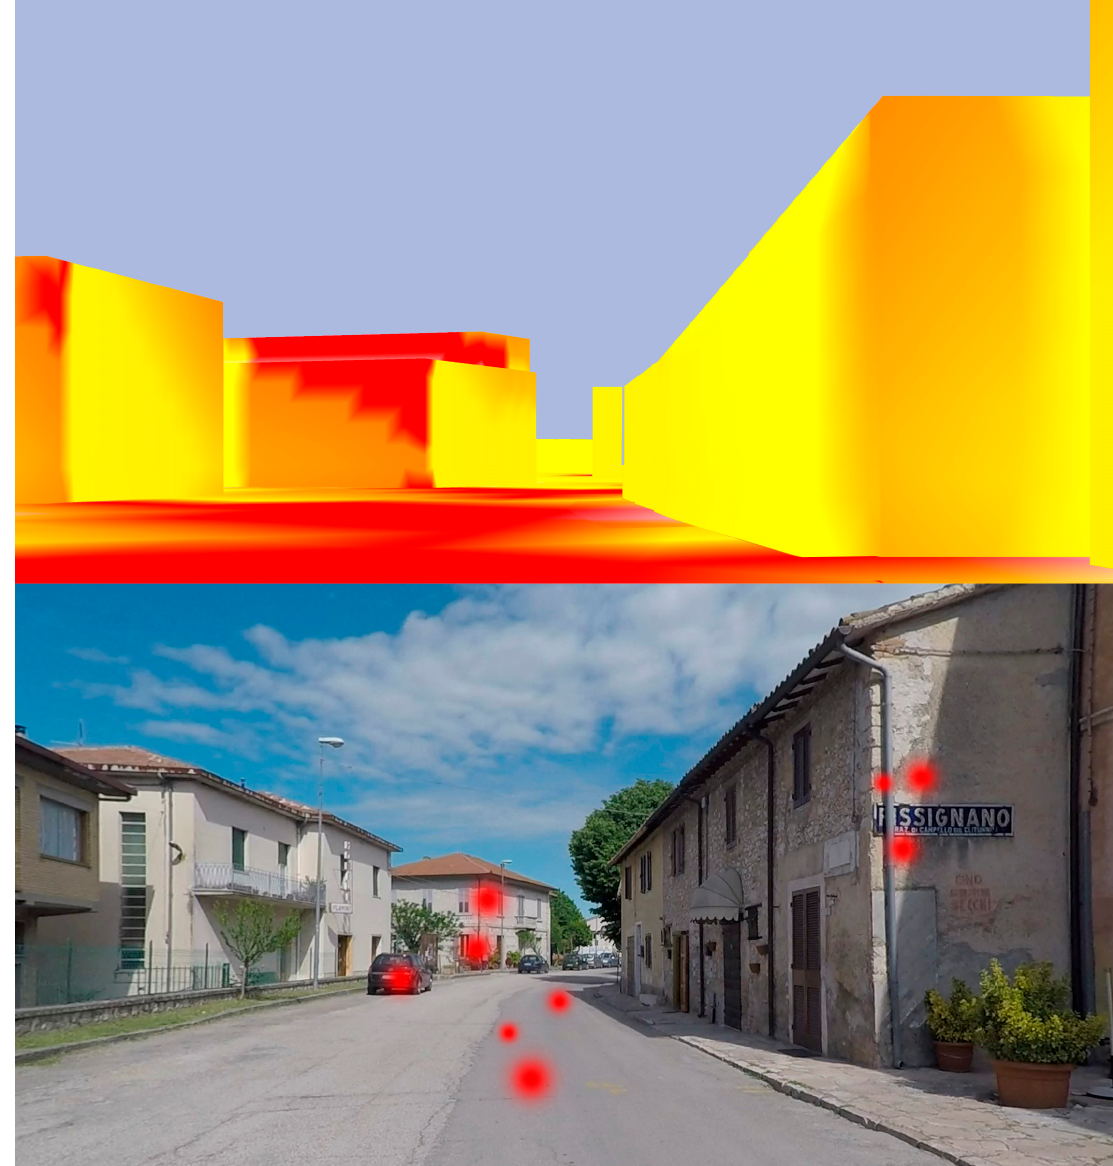
Figure 7. Comparison of the two methods of